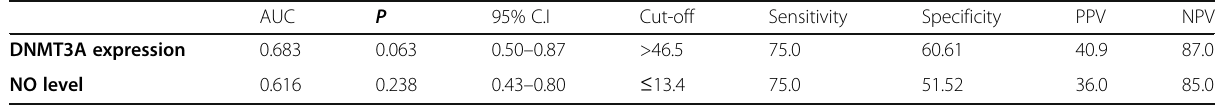
Table 3 Agreement (sensitivity, specificity) for different parameters to diagnose mutated cases cut-off point as described in the ROC curve AUC P 95% C.I